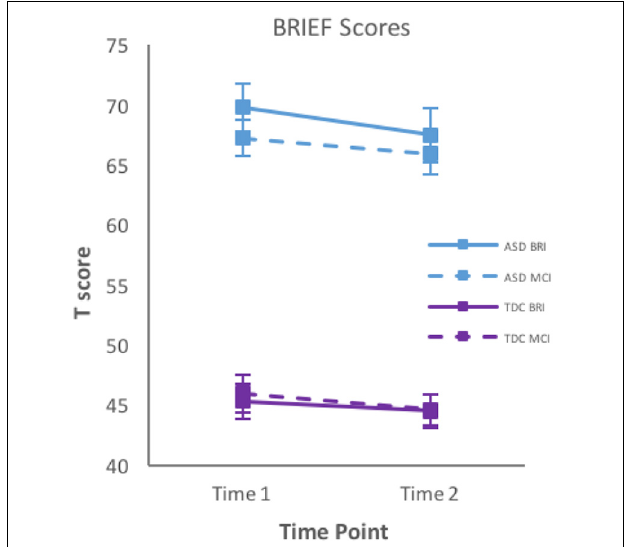
FIGURE 1 | Mean T scores and standard error bars of parent-reported BRIEF Behavior Regulation Index (BRI) and Metacognition Index (MCI) at time 1 and time 2. BRIEF, Behavior Rating Inventory of Executive Functioning; ASD, Autism Spectrum Disorder; TD, typically developing children.